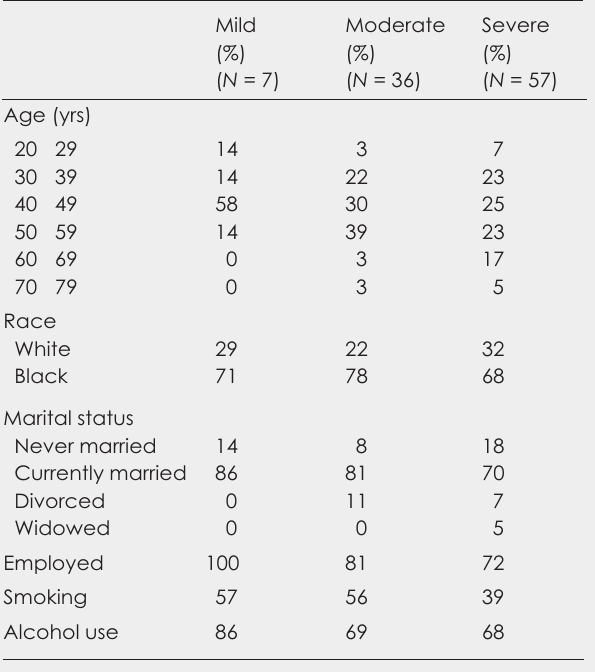
Table III. Comparison of characteristics and severity of erectile